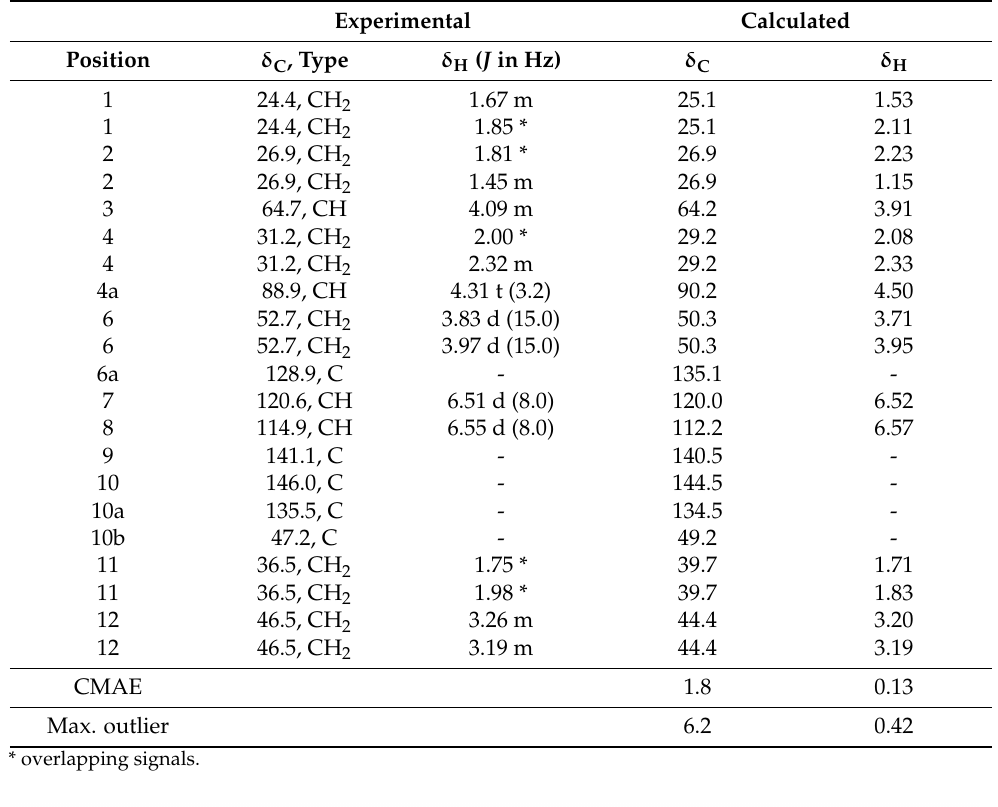
Table 1. Experimental and computed NMR spectroscopic data (400 MHz, CD 3 OD) for O -demethyl- norlycoramine ( 1 ).